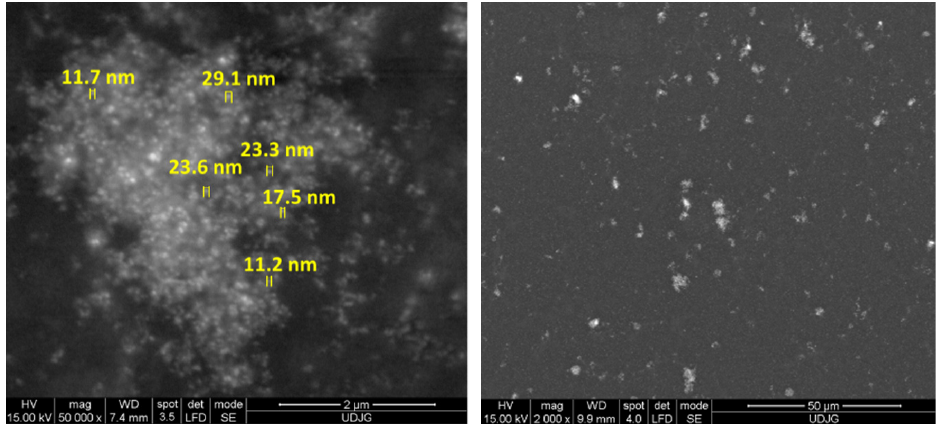
Figure 1. SEM micrographs of CeO 2 nanoparticles.